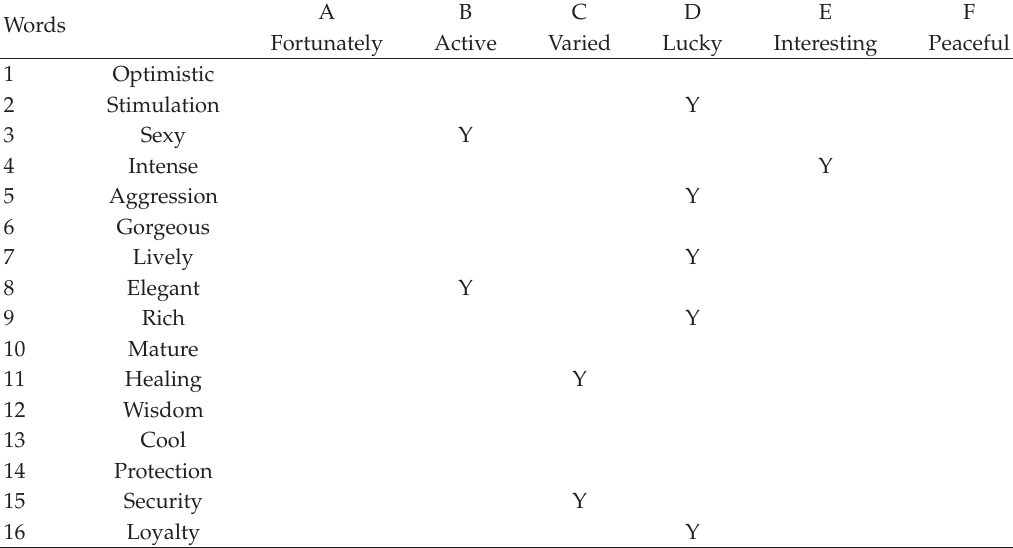
Table 5: 2-dimensional color style evaluation (cid:2) “Y”-selected (cid:3)